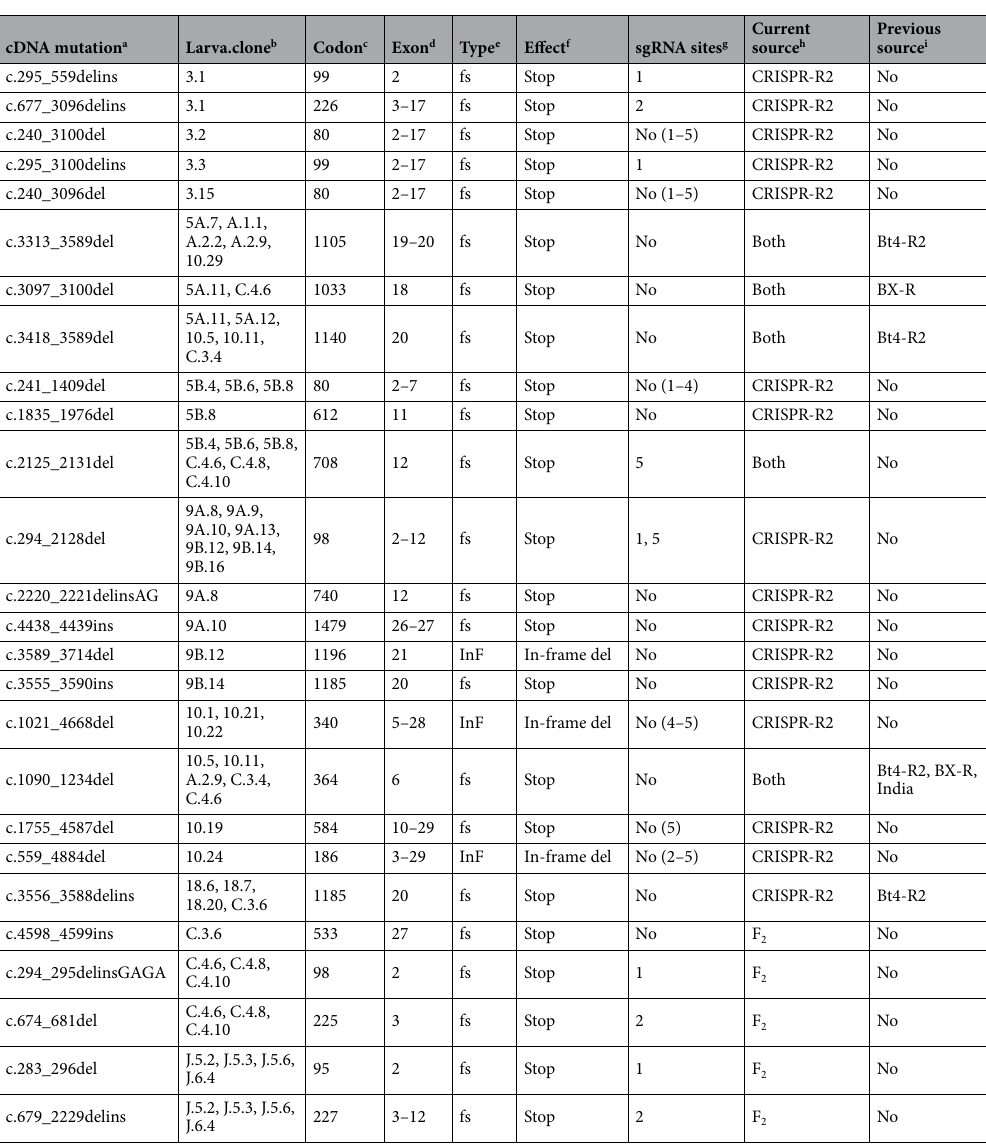
Table 2. Twenty-six PgABCA2 cDNA mutations in 11 Cry2Ab-resistant pink bollworm larvae from the CRISPR-R2 strain (n = 5) and CRISPR-R2 X APHIS-S F 2 progeny (n = 6). a cDNA nomenclature showing the nucleic acid sequence changes in PgABCA2 (MG637361.1) based on the recommendations by the Human Genome Variation Society (http:// www. hgvs. org/). b Entries start with a number for the five larvae from the CRISPR-R2 strain (3, 5, 9, 10 and 18) and with a letter for the six larvae from F 2 progeny of three single-pair families from CRISPR-R2 X APHIS-S crosses (A, C and J). For each entry, the first number indicates the larva and the second number indicates the clone (e.g., 3.1 indicates larva 3, clone 1). For 5A and 5B as well as 9A and 9B, two distinct PCR products (A and B) were cloned and sequenced from a single larva. c Codon number beginning from the initiation codon and indicating disrupted position in the coding sequence. d Disrupted exon in the coding sequence. e Type of mutation (fs, frame shift; InF, in-frame mutation). f Result of mutation in the coding sequence (Introduction of premature stop codon; In-frame del; In-frame deletion). g Numbers 1, 2 or 5 indicate the sgRNA site directly affected; no indicates none of the five sgRNA sites were directly affected and numbers in parentheses indicate sgRNA sites indirectly affected (mutations occurred in exons containing sgRNA sites). h Source of larvae in the current study: CRISPR-R2, F 2 progeny of single-pair families from CRISPR-R2 X APHIS-S, or both. i No indicates not found in previous studies; other entries indicate the same cDNA mutation was previously found in one or more of the following sets of Cry2Ab-resistant insects: lab- selected Bt4-R2 and BX-R strains from Arizona and field-selected populations from India 29,30